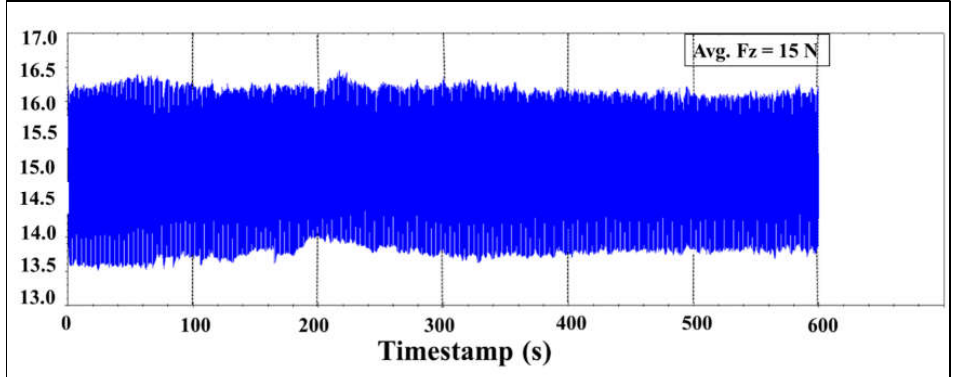
Figure 9. Generation of normal force (F z ) graph for Al359/Si 3 N 4 /Eggshell surface composites.